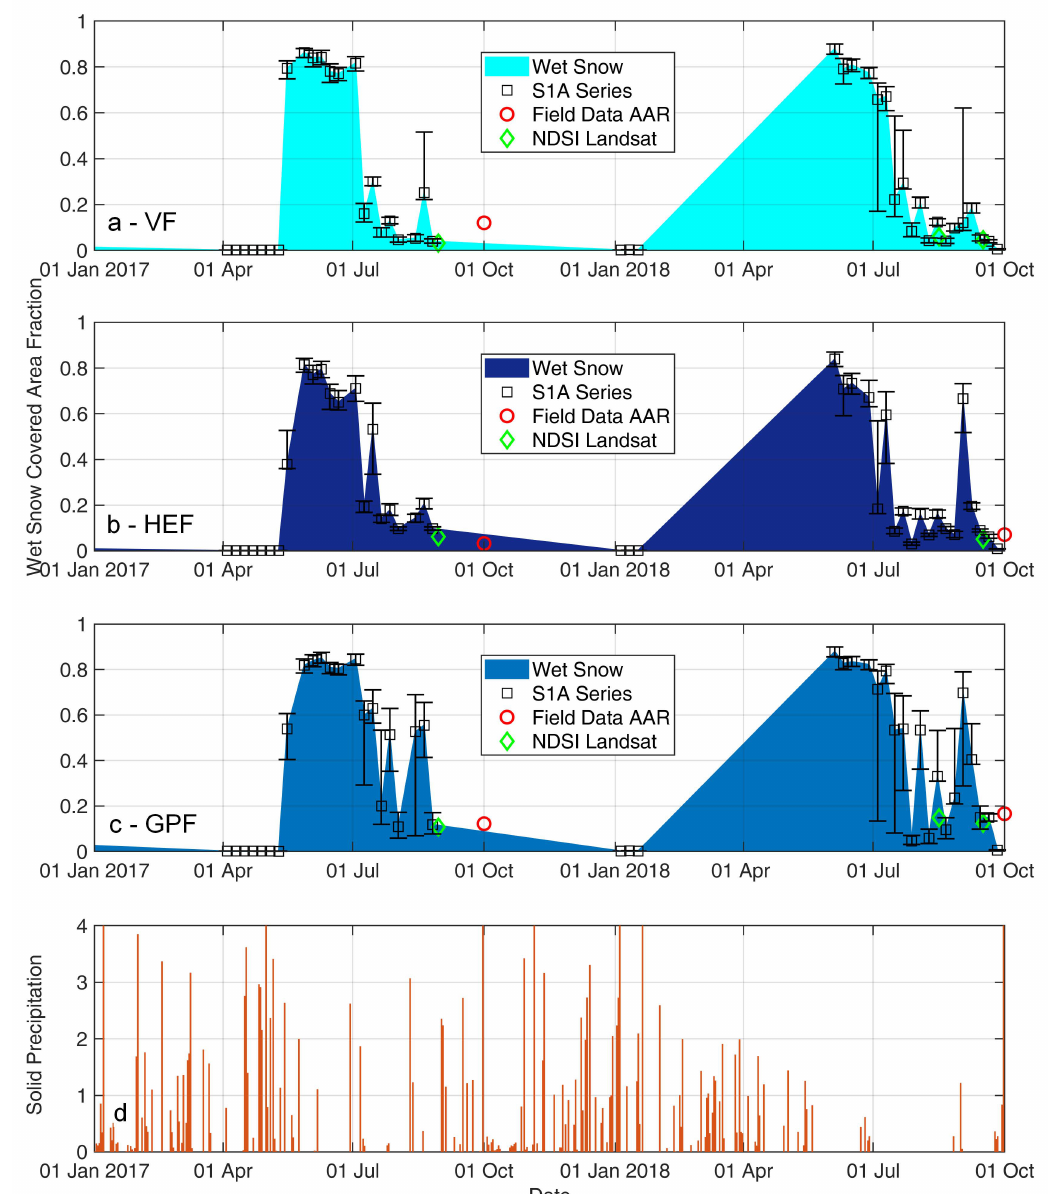
Figure 6. Wet snow covered area fraction for Sentinel-1 (S1) series per area of interest (AOI) Vernagtferner (VF) ( a ), Hintereisferner (HEF) ( b ), Gepatschferner (GPF) ( c ) and results for the new snow index ( d ) from January 2017–October 2018. Black rectangles display S1 scenes with error bars for uncertainties in thresholds, red circles show field data determined accumulation area ratio (AAR) and green diamonds display results for the normalized difference snow index (NDSI) from Landsat images and snow classification results from Sentinel-2 data. Field data for the AOI GPF in ( c ) were only acquired for